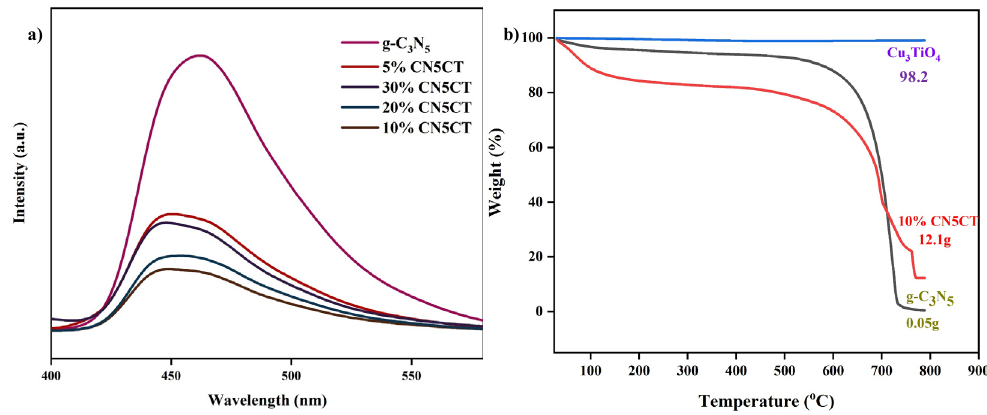
Figure 5. ( a ) PL emission spectra of g-C 3 N 5 , 5% CN5CT, 30% CN5CT, 20% CN5CT, 10% CN5CT ( b ) TGA analysis of Cu 3 TiO 4 , g-C 3 N 5, and 10% CN5CT nanocomposite.